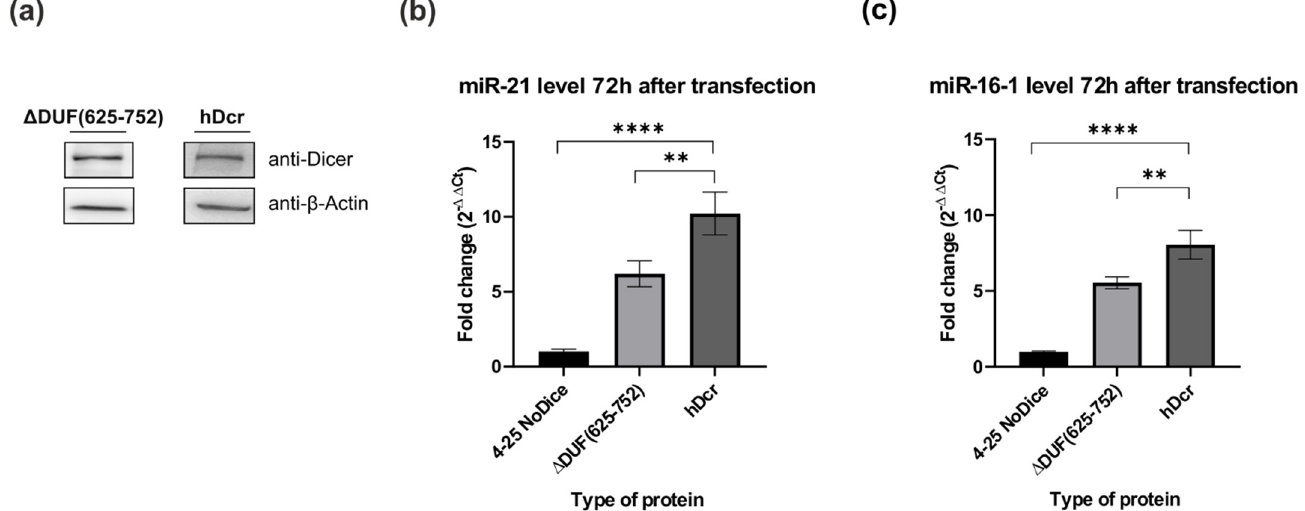
Figure 3. Comparison of miRNA levels produced in NoDice cells expressing ∆ DUF(625-752) and hDcr. ( a ) Western blot analysis of ∆ DUF(625-752) and hDcr expressed in 293T NoDice cells. Cells were harvested and analyzed by Western blotting with anti-Dicer and anti- β -Actin antibodies 72 h after transfection with the respective expression plasmids. ( b , c ) Results of the RT-qPCR analysis of the level of endogenous, mature miR-21 ( b ) and miR-16-1 ( c ) in the 293T NoDice cells (a negative control), or 293T NoDice cells expressing either ∆ DUF(625-752) or hDcr. 72 h after transfection, cells were harvested and total RNA was isolated. miRNA levels were determined by RT-qPCR and normalized to the expression of U6 snRNA, as a reference gene. The values are averaged from three biological replicates as mean ± S.D. Data were analyzed by one-way ANNOVA test followed by Dunnett’s multiple comparisons test. The obtained p values are as follows, for miR-16-1: ** p < 0.0021, **** p < 0.0001; for miR-21: ** p < 0.0040, **** p < 0.0001.